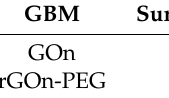
Table 1. Surface charge of GOn and rGOn-PEG aqueous dispersions at an initial concentration of 50 µ g mL − 1 and pH 7.4 ( n = 3)